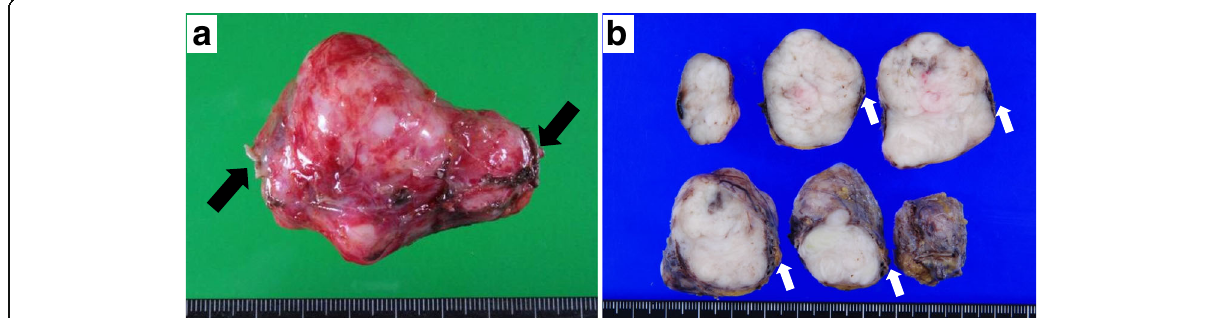
Fig. 4 Gross findings of the leiomyosarcoma. a , b The specimen consisting of a white solid tumor that measured 5.5 cm × 4.5 cm. b The ovarian vein (white arrow) can be seen passing through the dorsal side of the